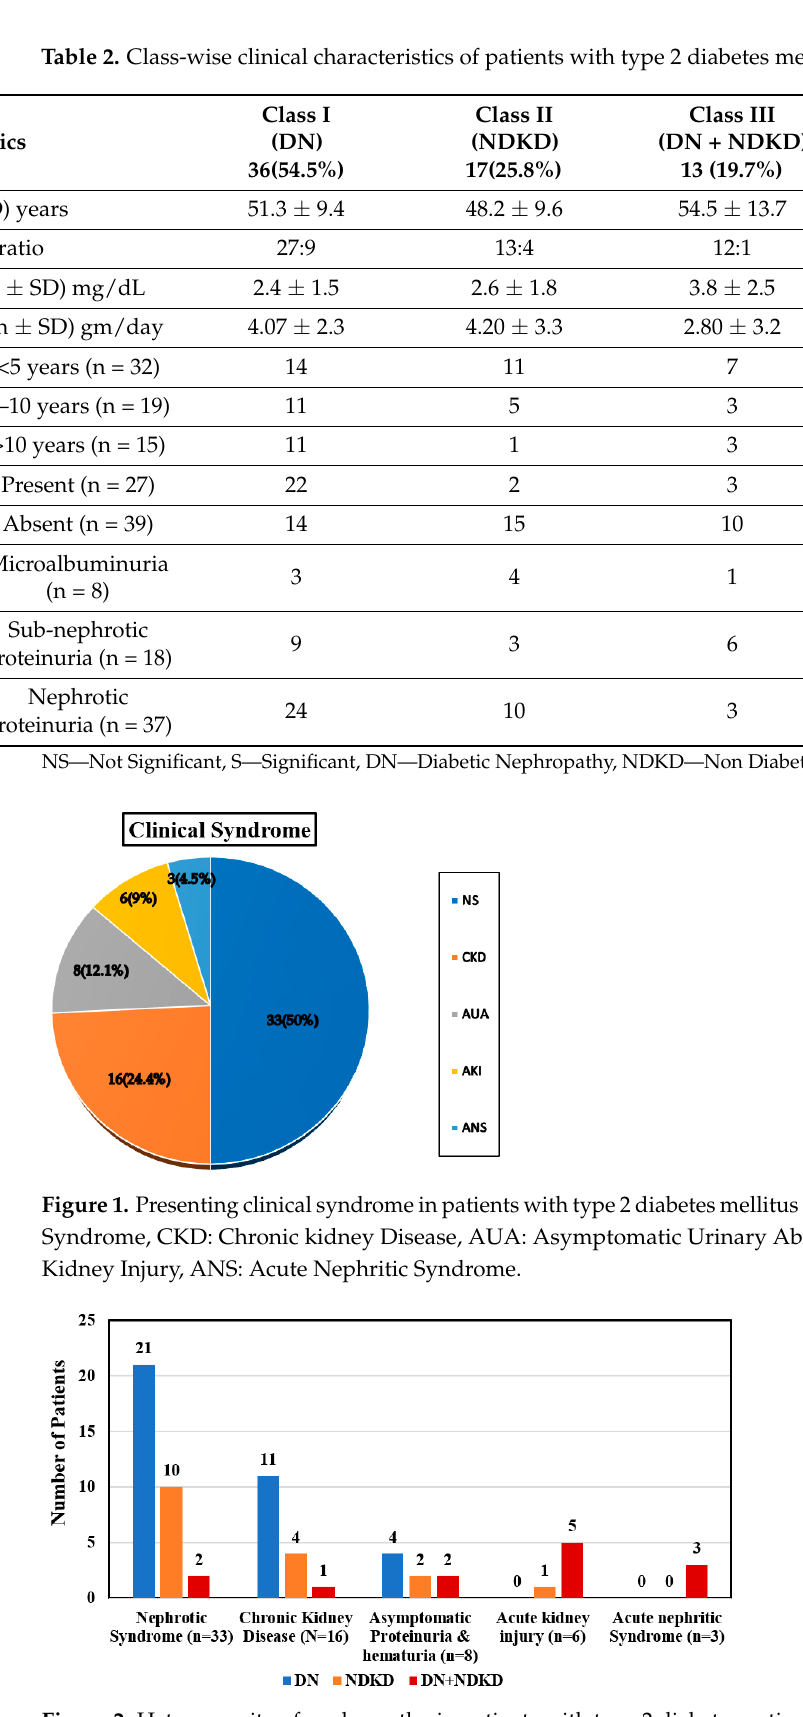
Figure 2. Heterogeneity of nephropathy in patients with type 2 diabetes patients with various clinical syndromes (n = 66). Table 3. Heterogeneity of NDKD in patients with type 2 diabetes mellitus patients (n = 30).